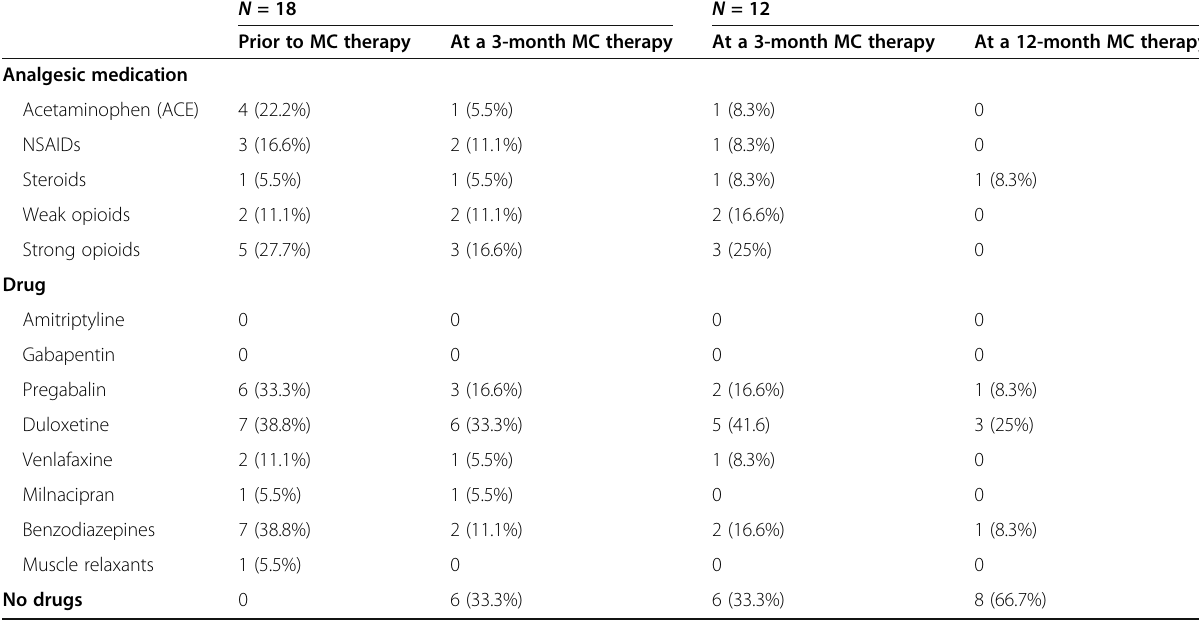
Table 14 Number of Italian patients taking pharmacological treatment prior to, and during, medical cannabis therapy N =